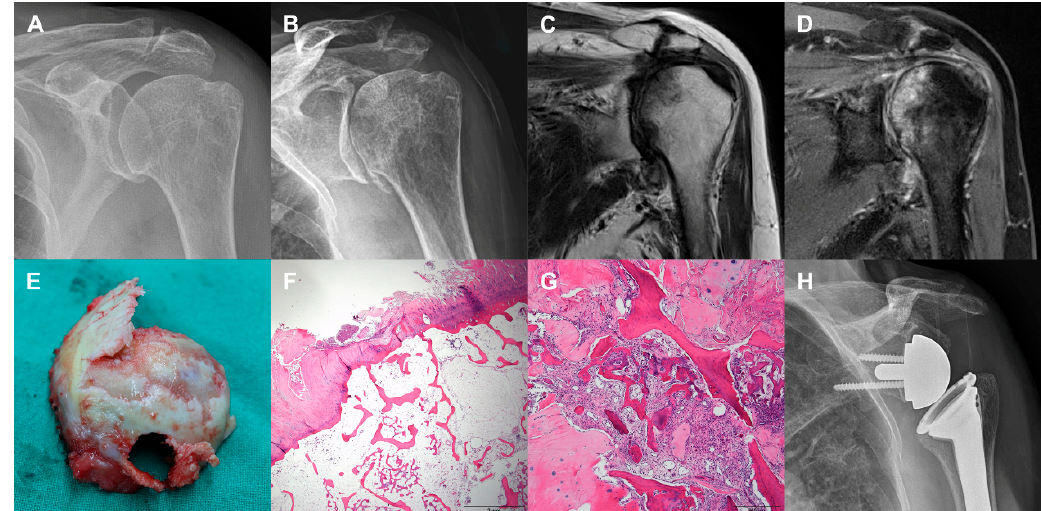
Figure 4. Case 1 (81-year-old woman). ( a ) No evidence of head collapse in plain radiograph at the time of onset of symptoms. ( b ) Subchondral fracture in plain radiograph taken at 4 months after onset of symptoms. ( c ) Low signal intensity band on T1-weighted MR image. ( d ) High signal intensity on T2-weighted MR image. ( e ) Exposure of subchondral bone with detached articular cartilage in photograph of resected humeral head. ( f ) Histologic findings showing degenerated and fibrillar articular surface and osteoid formation (hematoxylin-eosin stain, ×1.25). ( g ) Histologic findings showing regenerating bony trabeculae and fibrosis (hematoxylin-eosin stain, ×10). ( h ) Plain radiograph after RTSA.